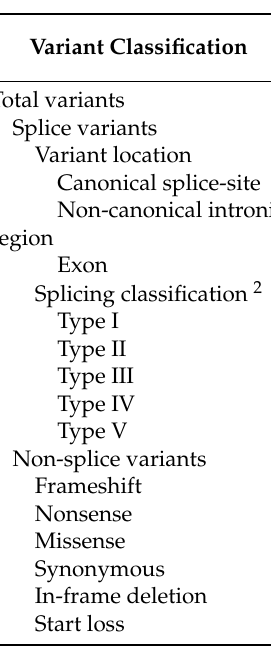
Table 1. Classification and description of the identified NF1